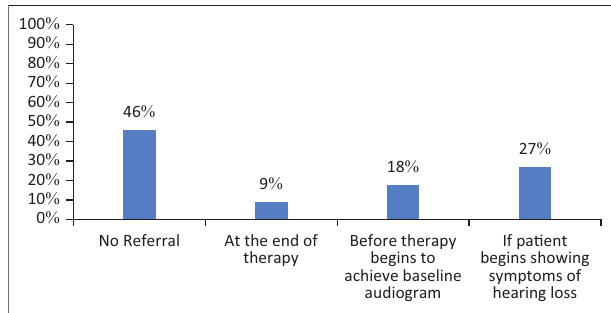
FIGURE 3: Percentage of paediatric oncologists who refer to audiologists for possible hearing loss management ( n = 11).